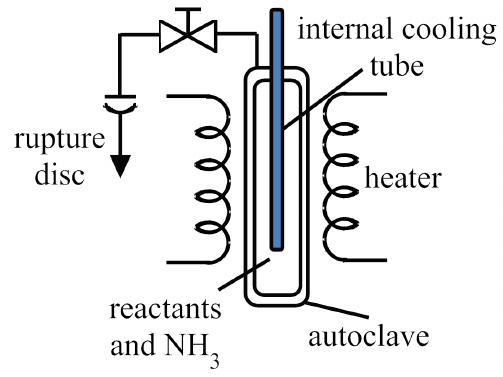
Figure 4. Flow chart of an ammonothermal autoclave with integrated cooling and external heating